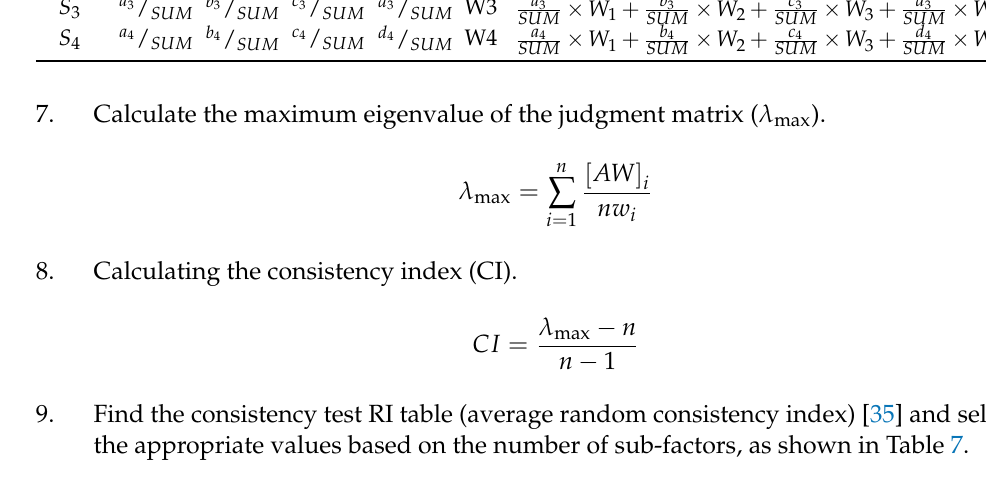
Find the consistency test RI table (average random consistency index) [35] and select the appropriate values based on the number of sub-factors, as shown in Table